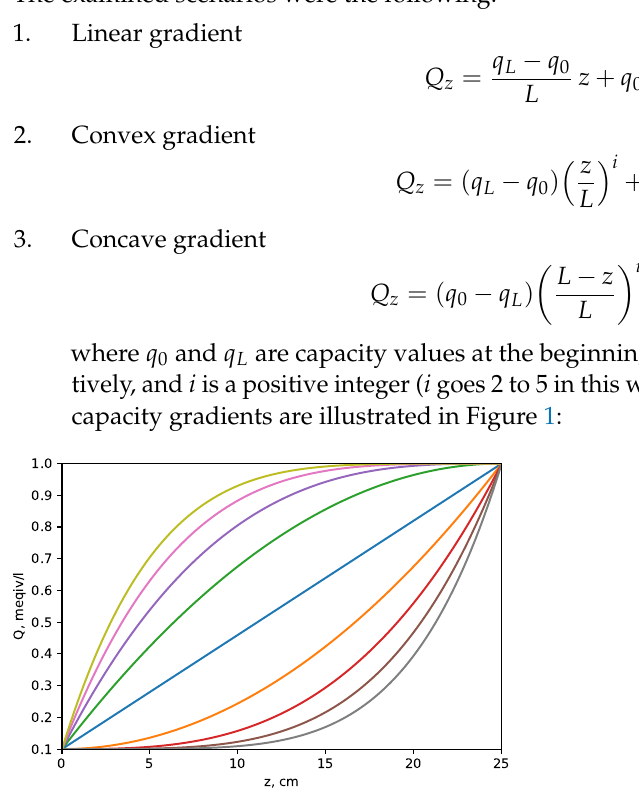
Figure 1. Profiles of the different capacity gradients used in this work. Linear (blue) curve is calculated by Equation (6). Parameter i of Equation (7) (convex curves): 2—orange, 3—red, 4—brown, 5—gray. Parameter i of Equation (8) (concave curves): 2—green, 3—purple, 4—ping,